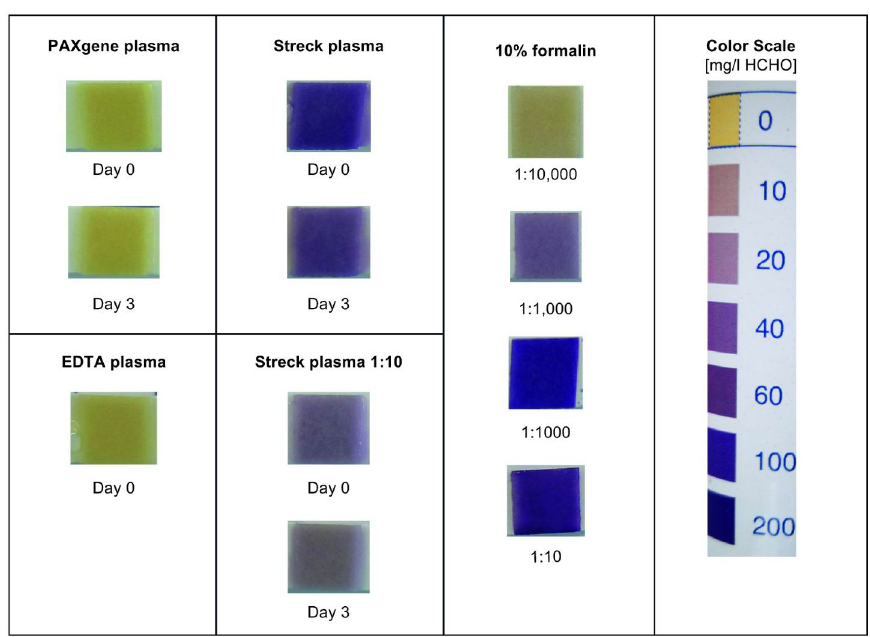
Fig 4. Formaldehyde detection. Formaldehyde content in plasma was analyzed and quantified using Quantofix Formaldehyde stripes.